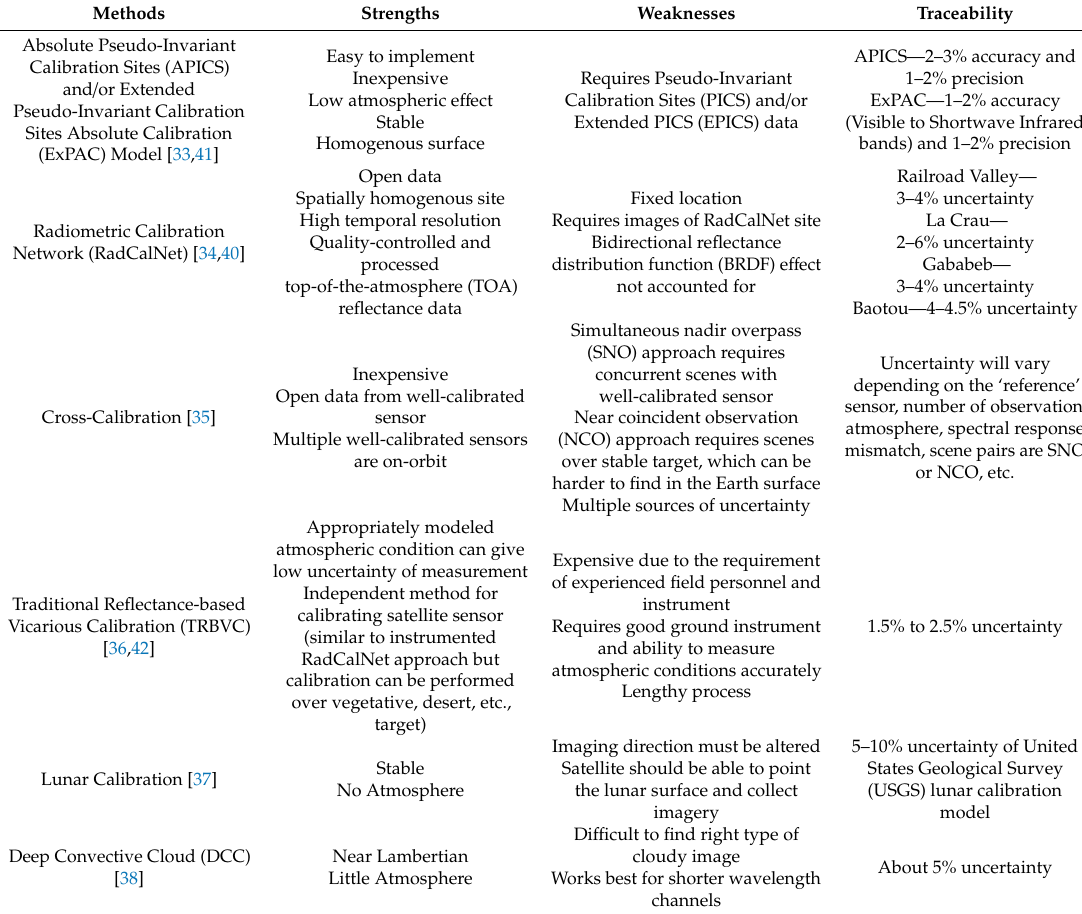
Table 1. Absolute Calibration